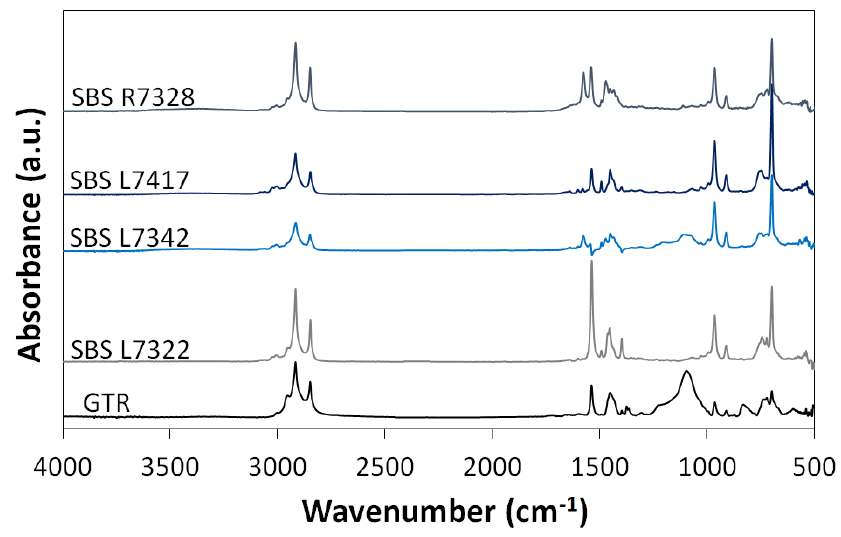
Figure 1. FTIR analysis of GTR and SBS copolymers.